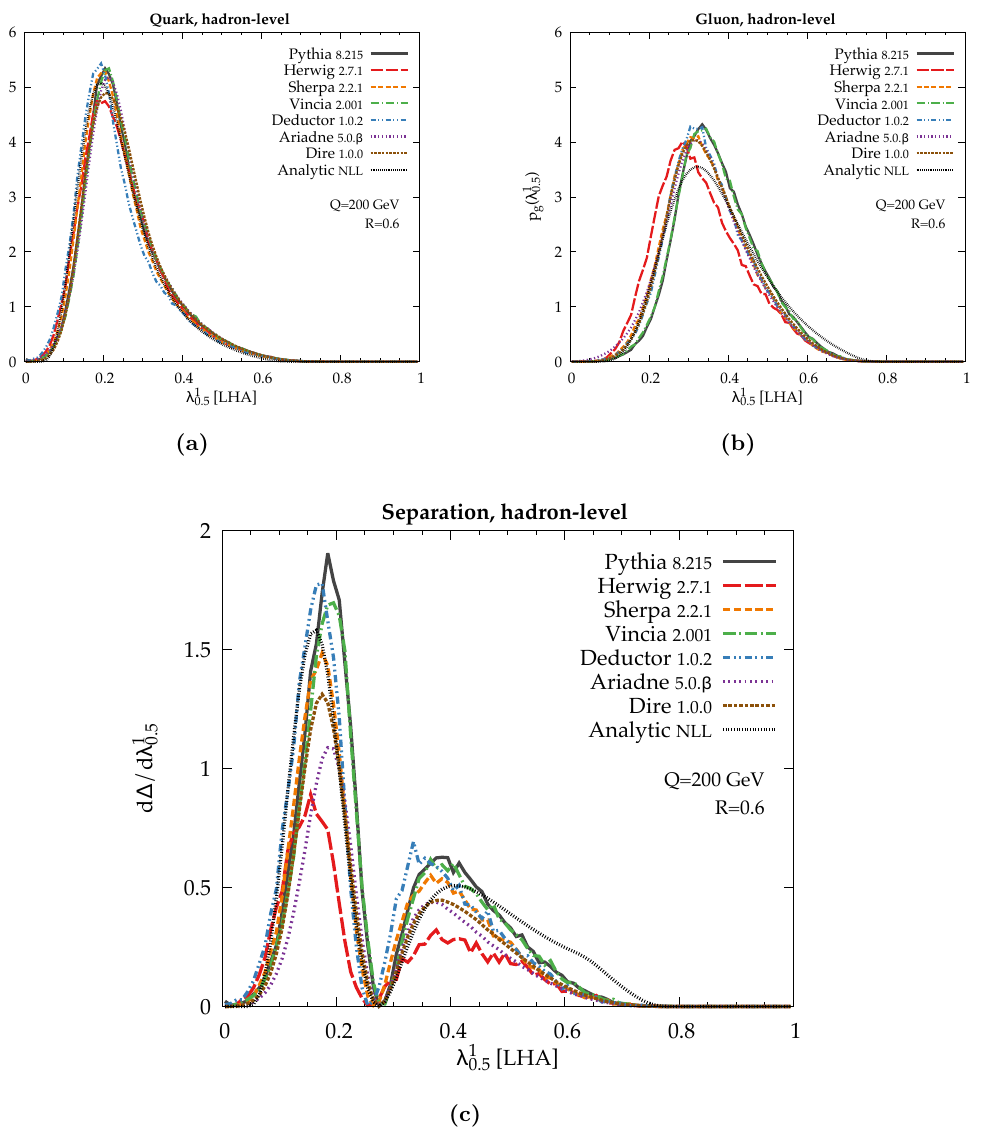
Figure 5. Hadron-level distributions of the LHA for (a) the e + e (cid:0) ! u (cid:22) u (\quark jet") sample, (b) the e + e (cid:0) gg (\gluon jet") sample, and (c) the classi(cid:12)er separation integrand in eq. (3.18). ! Seven parton-shower generators | Pythia 8.215 , Herwig 2.7.1 , Sherpa 2.2.1 , Vincia 2.001 , Deductor 1.0.2 , Ariadne 5.0. (cid:12) , and Dire 1.0.0 | are run at their baseline settings with center- of-mass energy Q = 200 GeV and jet radius R = 0 : 6. We also show the analytic NLL results from section